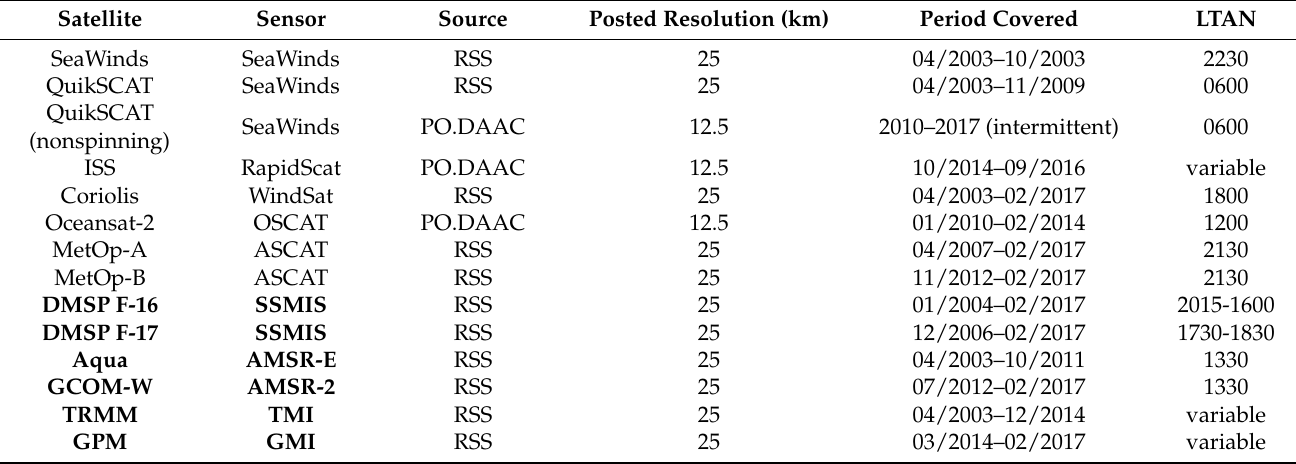
Table 1. Source and time period of satellite-derived ocean winds used in this investigation 1 . Bold font indicates sensors with a windspeed-only capability. DSMP LTAN drift is